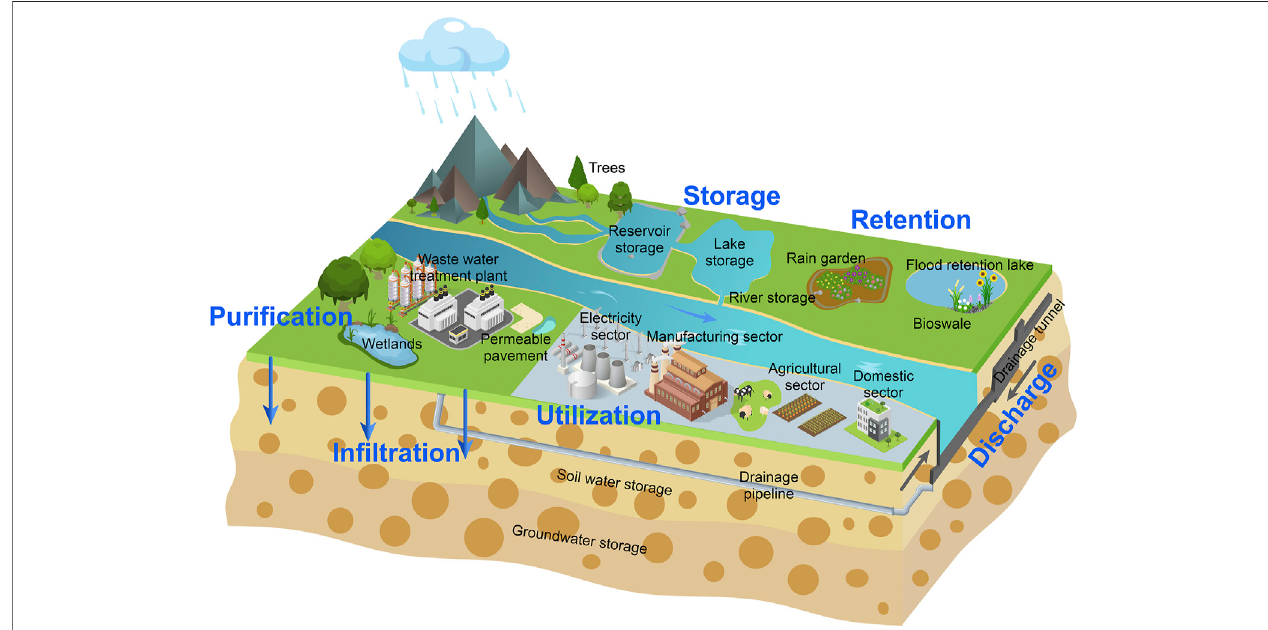
FIGURE 1 | The six hydrological processes in sponge city